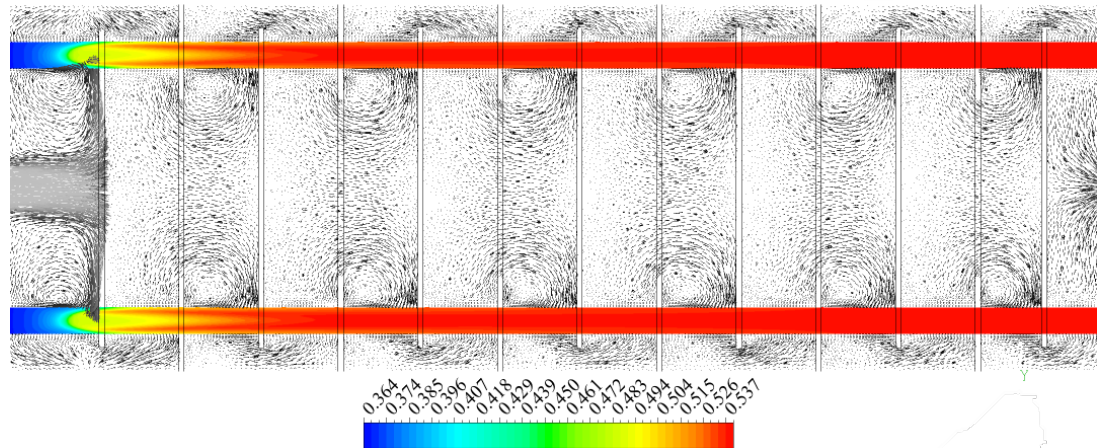
Figure 12. Reactor, longitudinal CH 4 mass fraction profile at x = 0, plane yz.